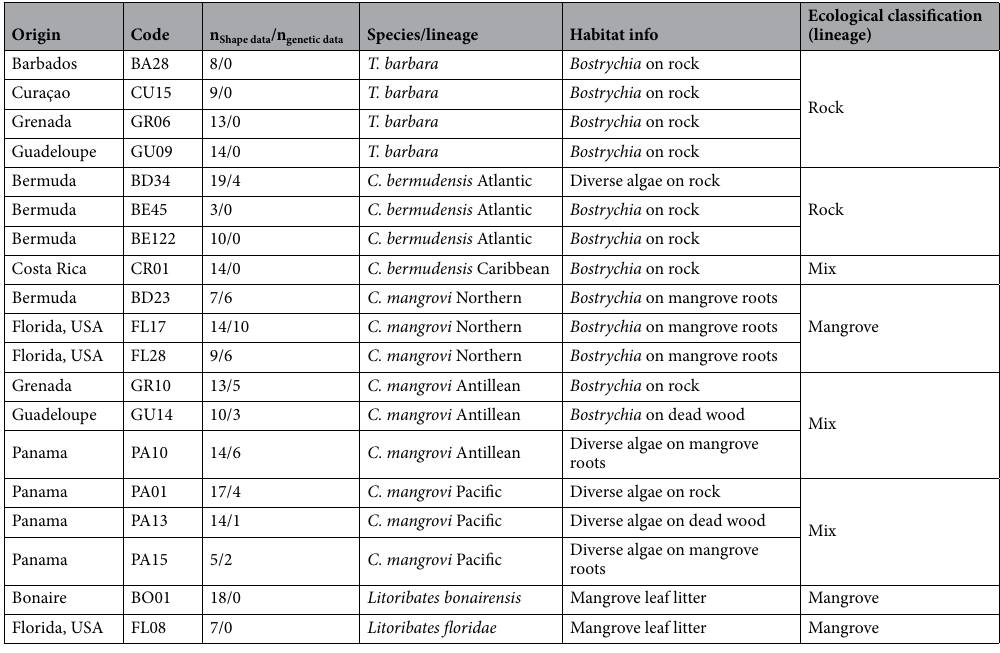
Table 1. Sample size (GM/MolGen), classification and information on the specific habitat for each species/